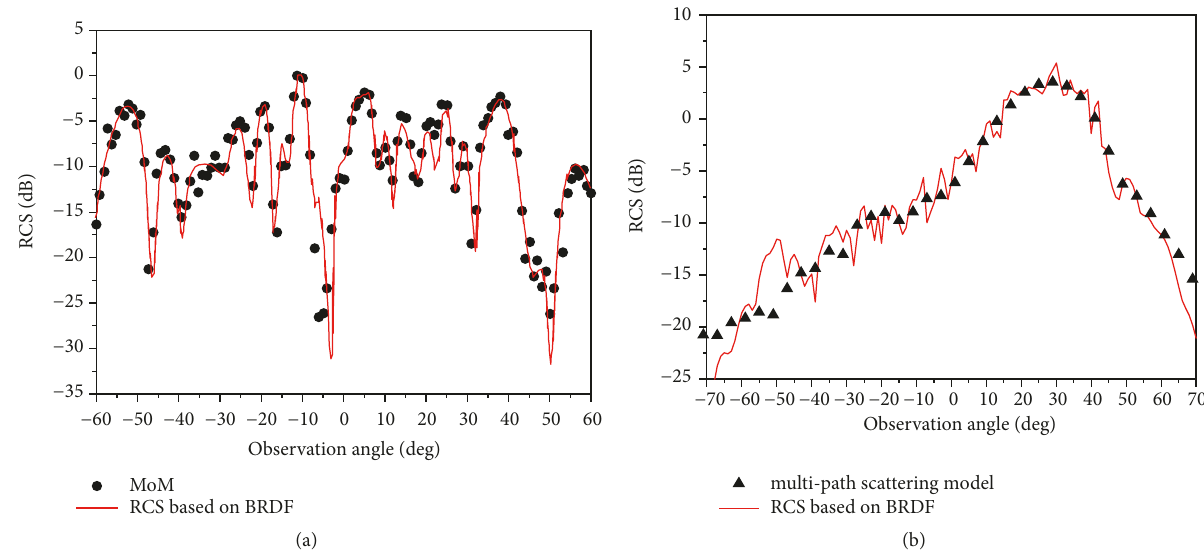
Figure 2: Validation of the presented method with the numerical methods. (a) The presented method is compared with MoM based on the rough land surface. (b) The presented method is compared with multipath scattering model based on the rough land surface covered by vegetation